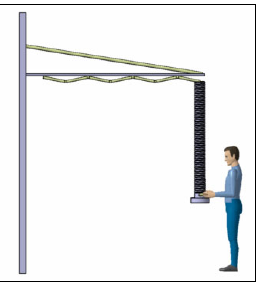
Figure 3. Proposed working position.